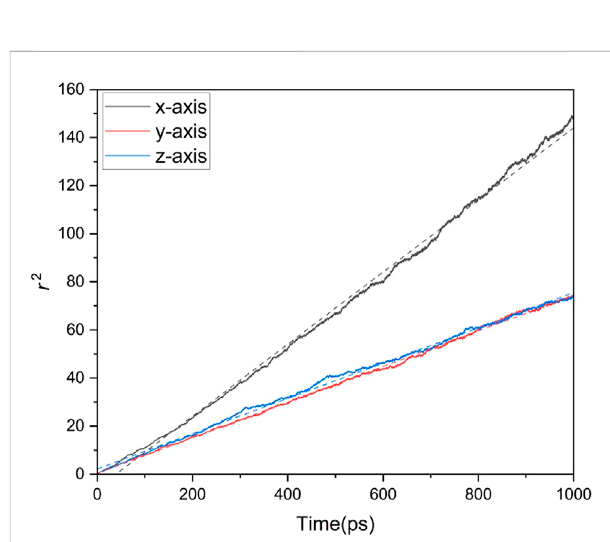
FIGURE 3 r 2 as a function of time for the glass 0.3 Na In this simulated experiment, a fi eld of 0.05 V/A was applied in the x -axis. The dotted lines represent the best linear fi t ( R 2 ≥ 0.997), as found by the OriginPro 2019 software. The fi rst 100 ps were discarded for this calculation to guarantee a steady-state diffusion